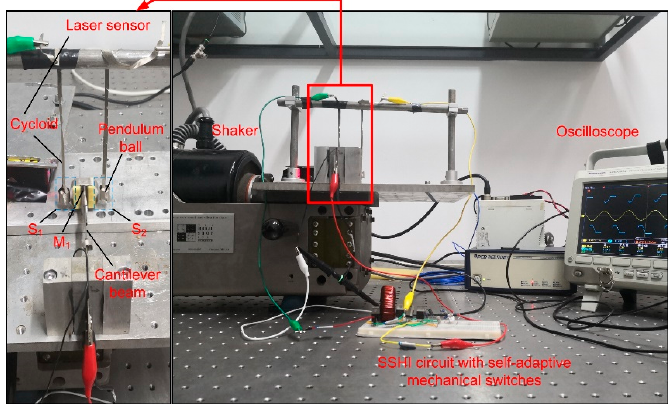
Figure 5. Experimental set-up and prototype.